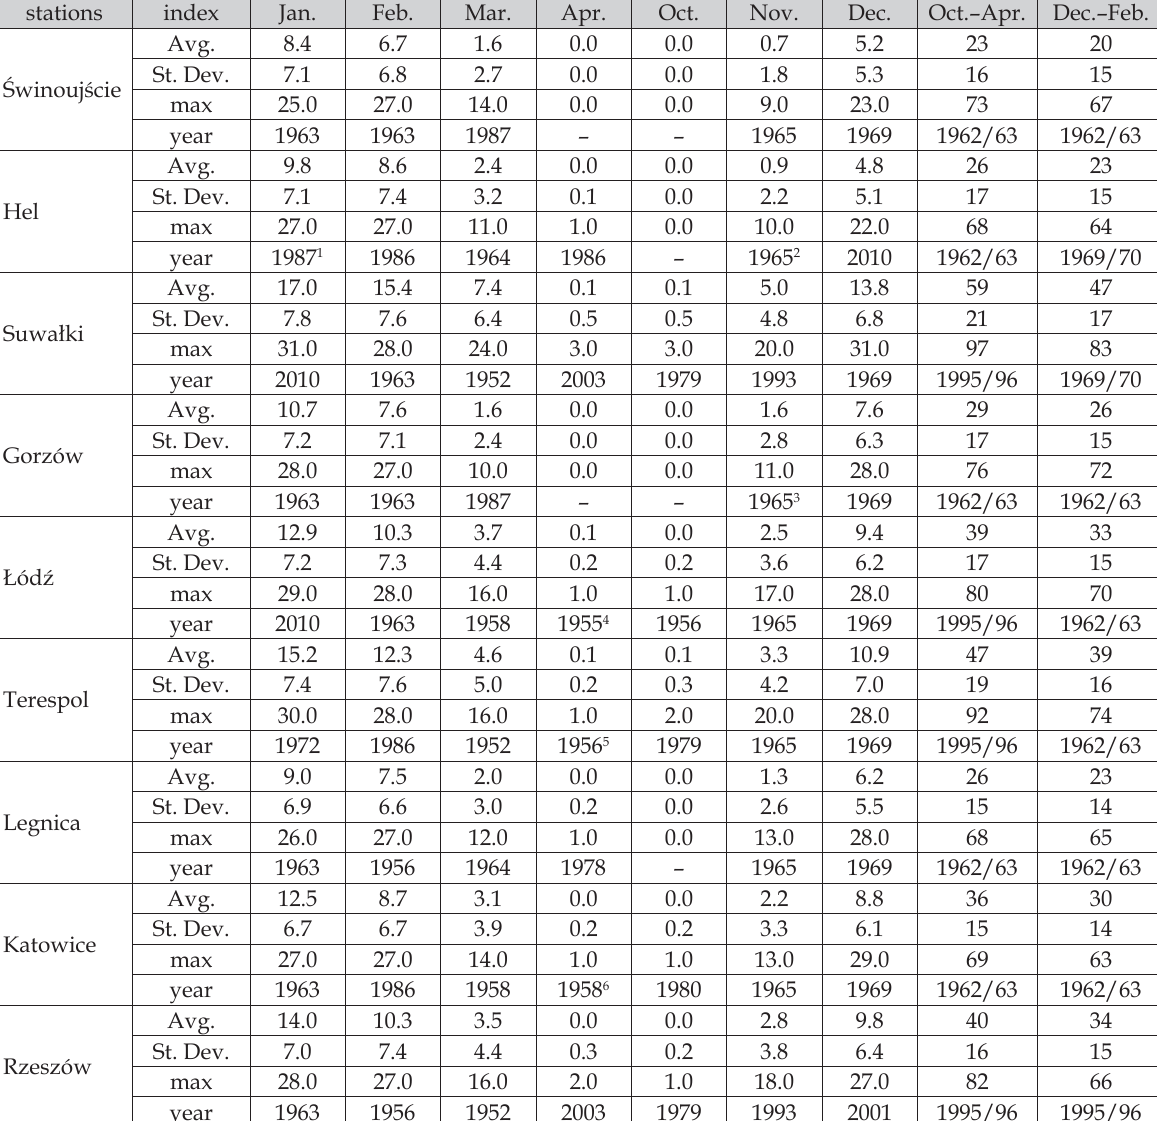
Table 1. Average monthly and seasonal number of ice days in the period January 1951–March 2014 at stations representing each grid box for which circulation classification